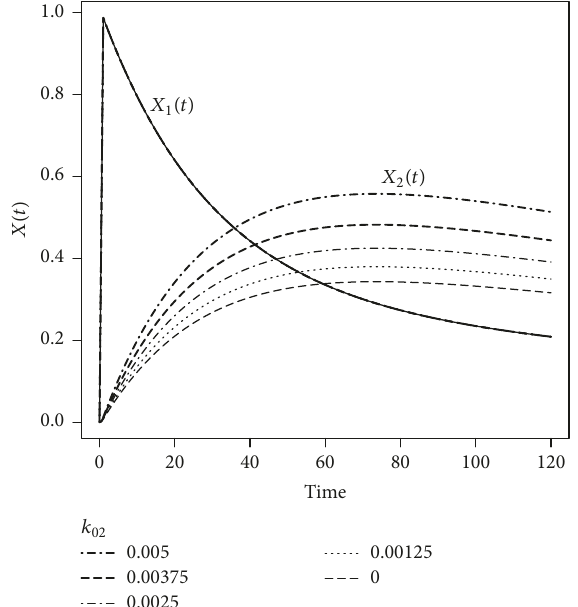
Figure 3: Time courses of model state trajectories 𝑥 1 (𝑡) (measured) and 𝑥 2 (𝑡)